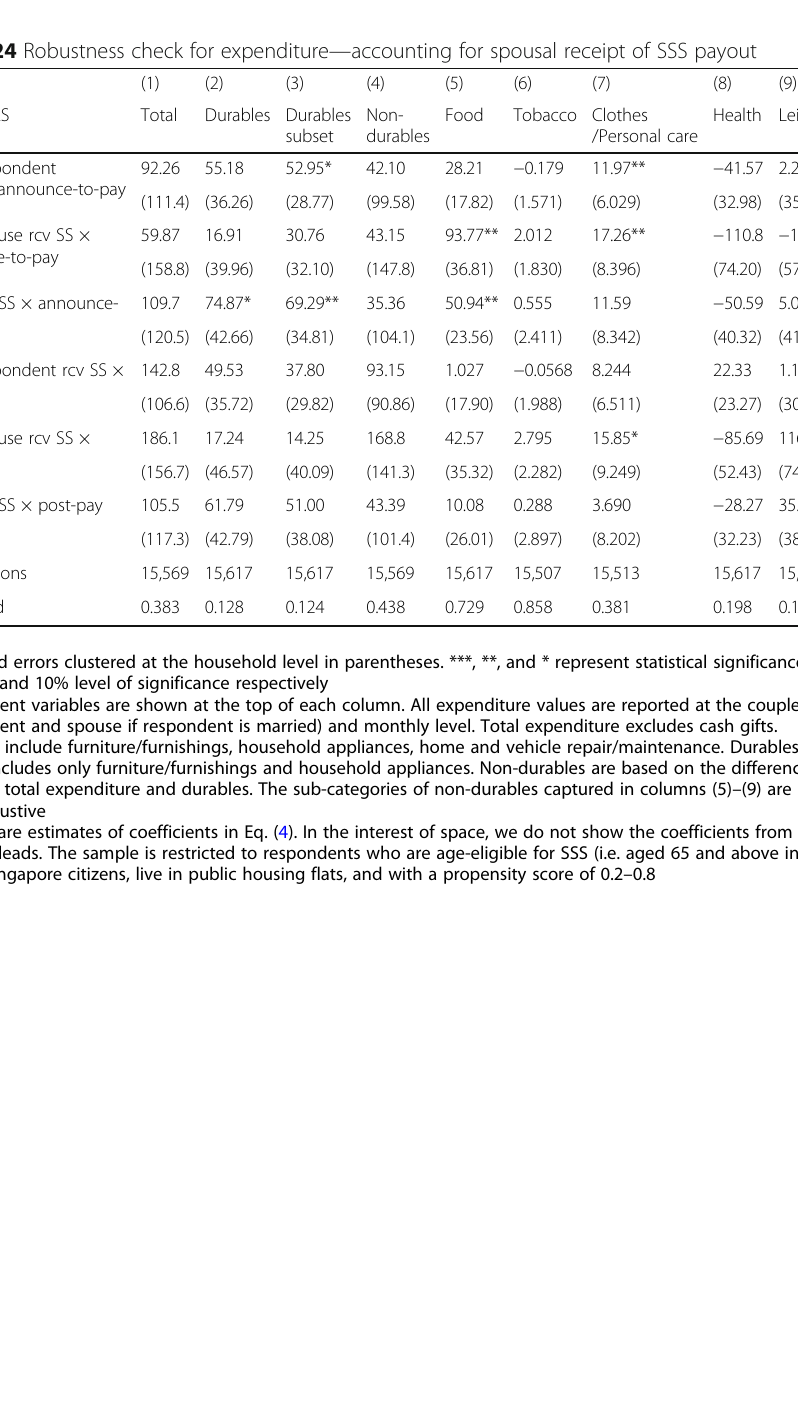
Table 24 Robustness check for expenditure — accounting for spousal receipt of SSS payout VARIABLES Total Durables Durables Only respondent rcv SS × announce-to-pay